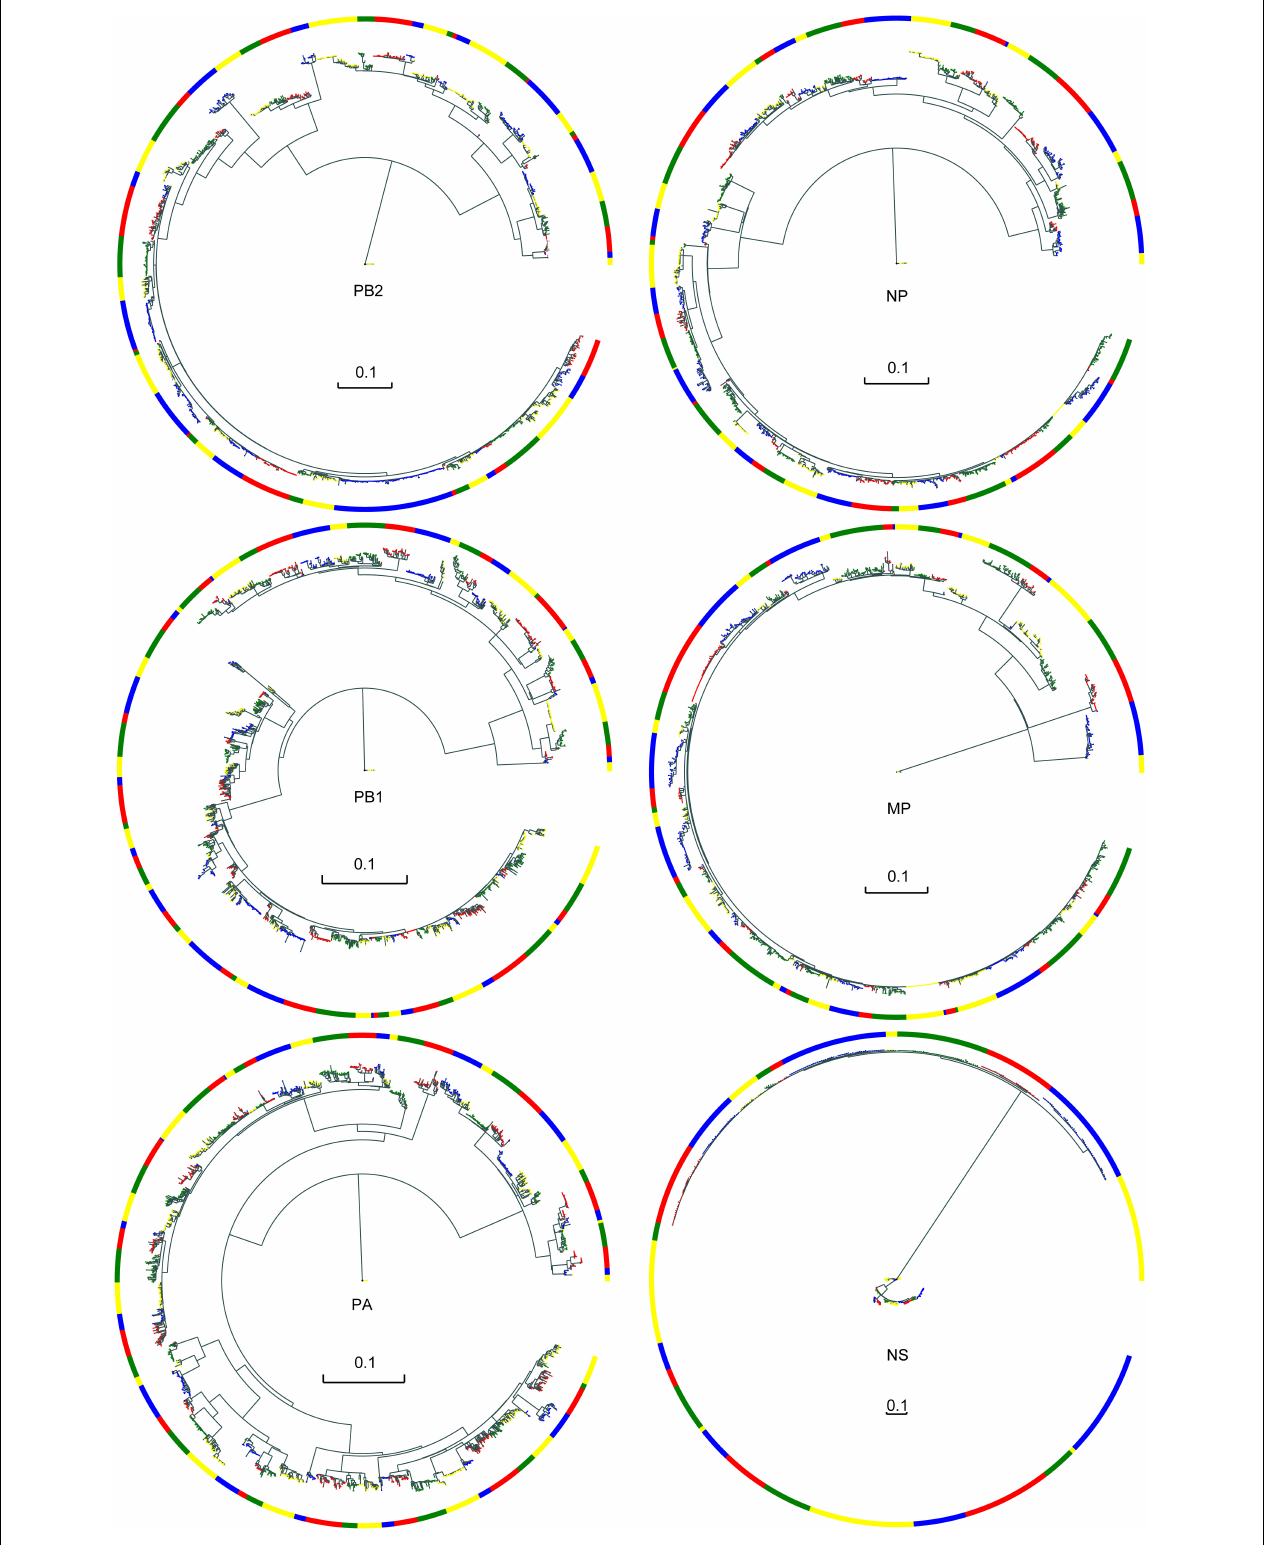
FIGURE 1 | Evolutionary trees and typical clusters of the core gene pool. The branches are colored according to their different typical clusters. Color blocks are visual representations of different typical clusters. Each color block represents a typical cluster; the colors themselves have no special meaning.